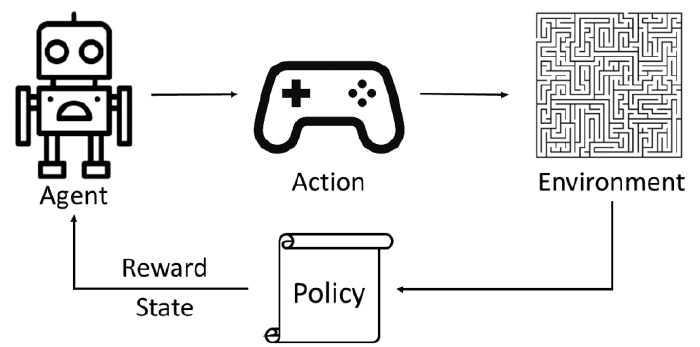
Figure 3. Reinforcement learning mechanism.